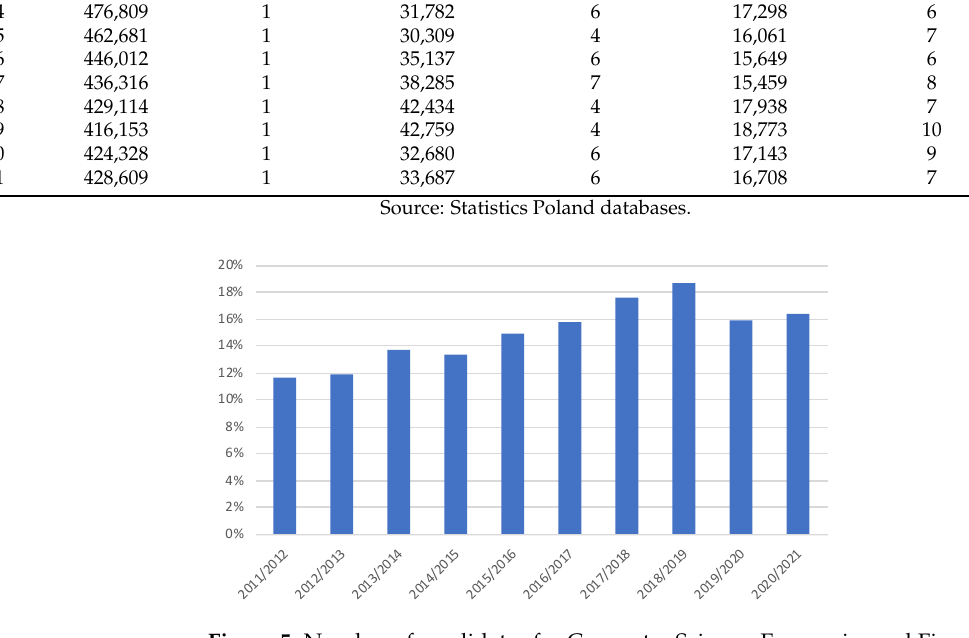
Figure 5. Number of candidates for Computer Science, Economics and Finance and Accounting as a percentage of all new admissions to higher